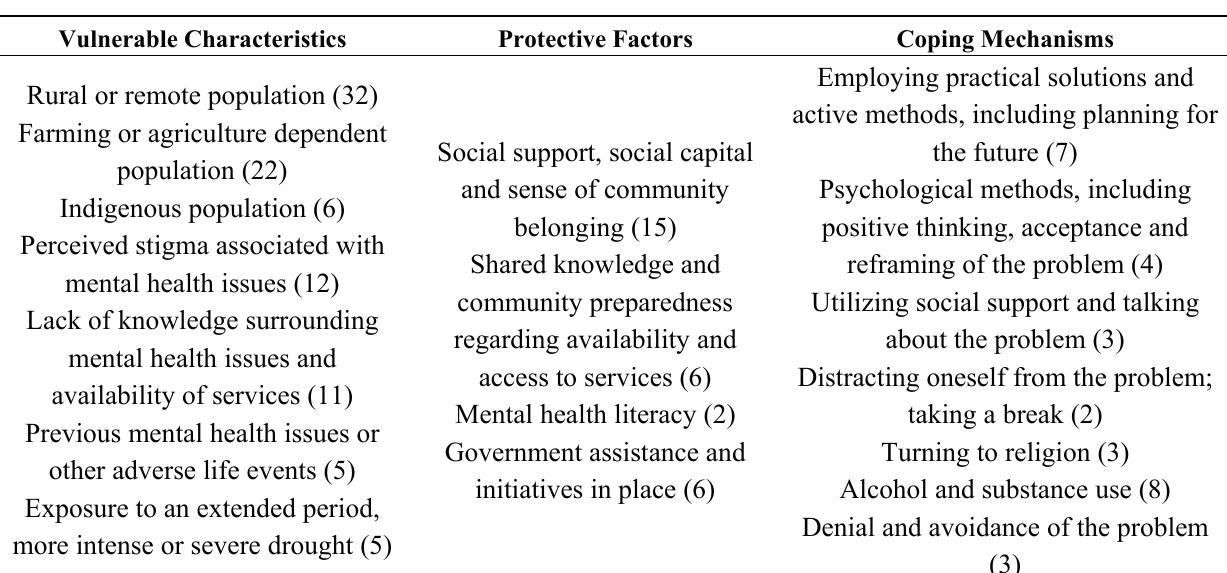
Figure 6. Mental health outcomes related to the environmental degradation of one’s home. Table 2. Vulnerabilities, protective factors and coping mechanisms for mental health effects of